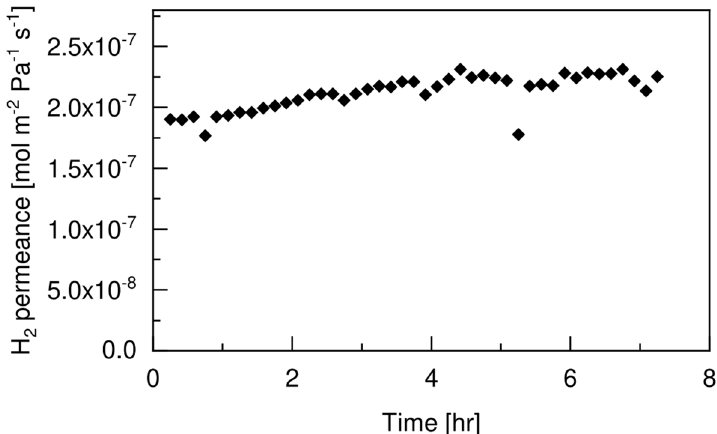
Figure 7. Membrane performance over time under fluidization conditions at 500 °C, ΔP = 2 bar, u 0 /u mf = 5 and feeding a mixture of 60 vol% H 2 and 40 vol% N 2